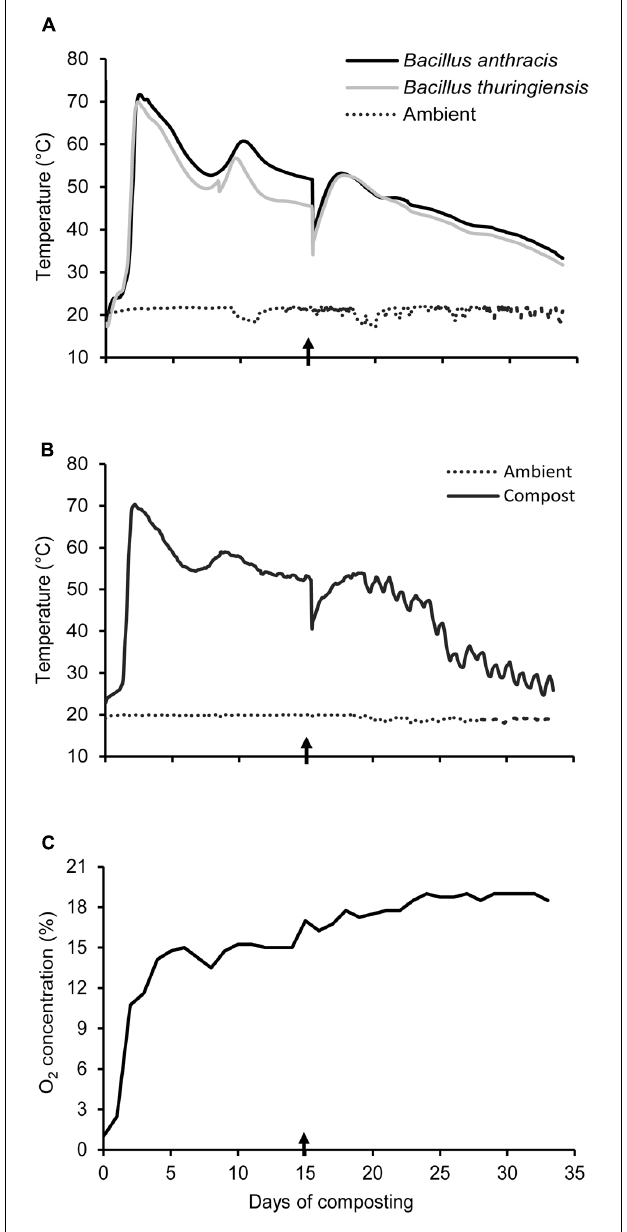
FIGURE 2 | (A) Temperature during composting of feedlot cattle manure containing B. thuringiensis and B. anthracis spores under containment, and (B) temperature and (C) O 2 concentration during composting of feedlot cattle manure outside of containment. Arrows indicate the date when compost was mixed and